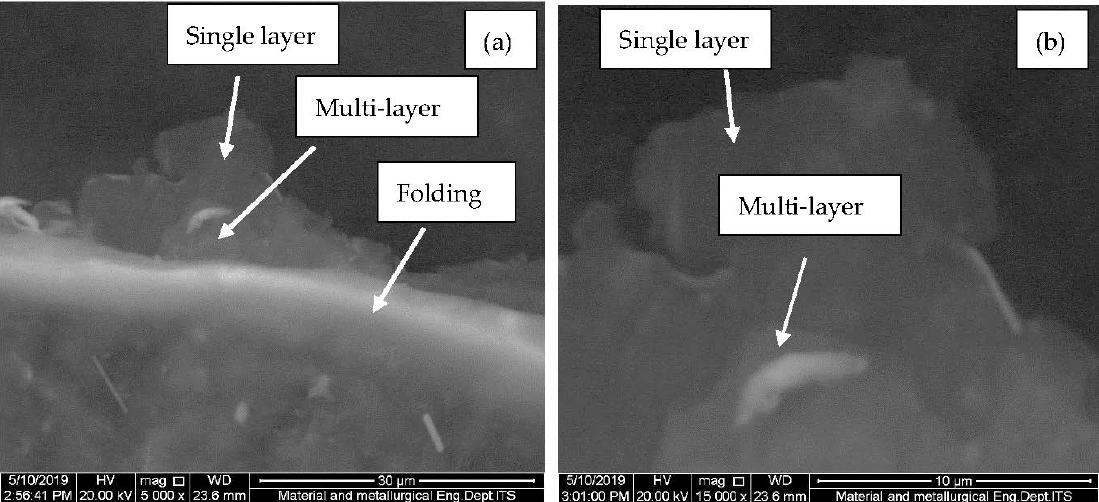
Figure 1. SEM image of r-GO, 5000 magnifications ( a ) and 15,000 magnifications ( b ).